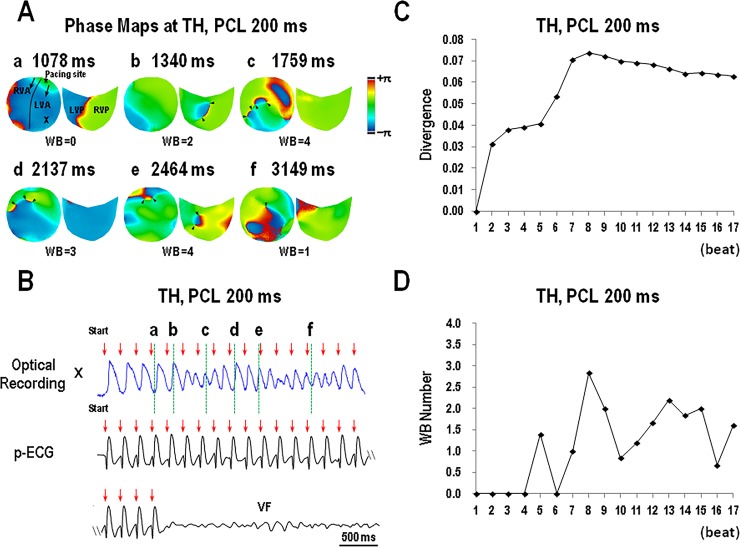
Simultaneous recordings of epicardial activations (A), pseudo-ECG (B), dynamic changes of divergence (C), and epicardial wavebreaks (D) at the start of burst ventricular pacing at pacing cycle length (PCL) 200 ms during therapeutic hypothermia (TH, 30°C) in an episode of high divergence (data is from heart #7). Note that the divergence increased to 0.031 at the 2nd beat and remained as high as 0.63 at the 17th beat. VF was inducible after stopping pacing (B). Black triangles in panel A indicate points of wavebreak (WBs).